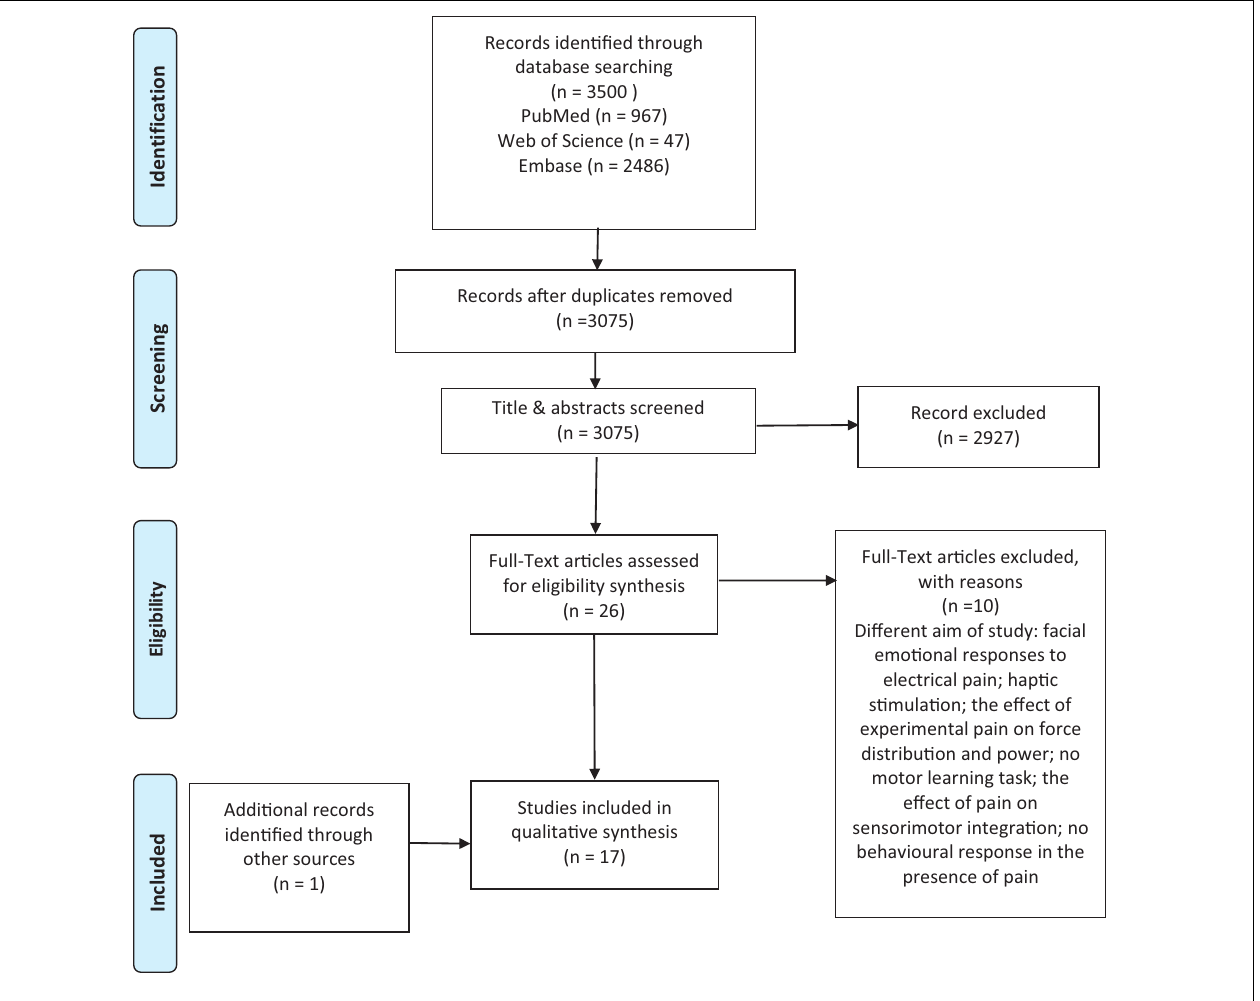
FIGURE 1 | Flowchart of study selection